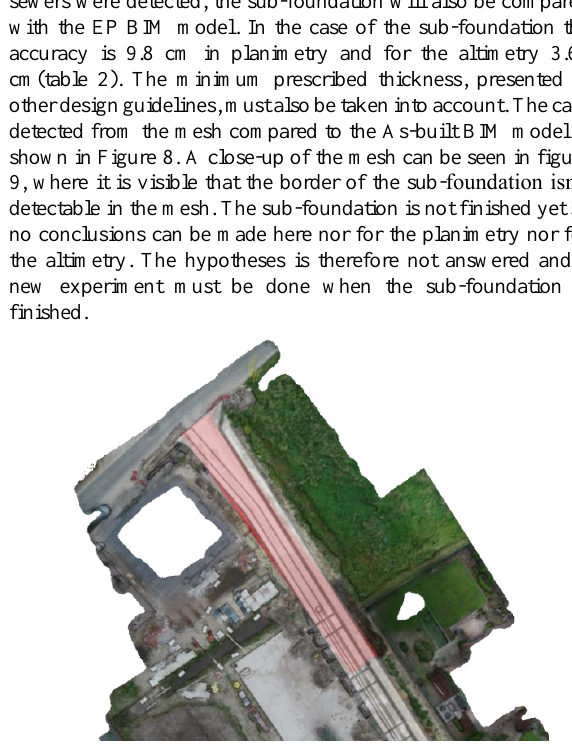
Figure 8. Detection of sub-foundation out of a mesh compared to the as -design BIM. The sub-foundation is not